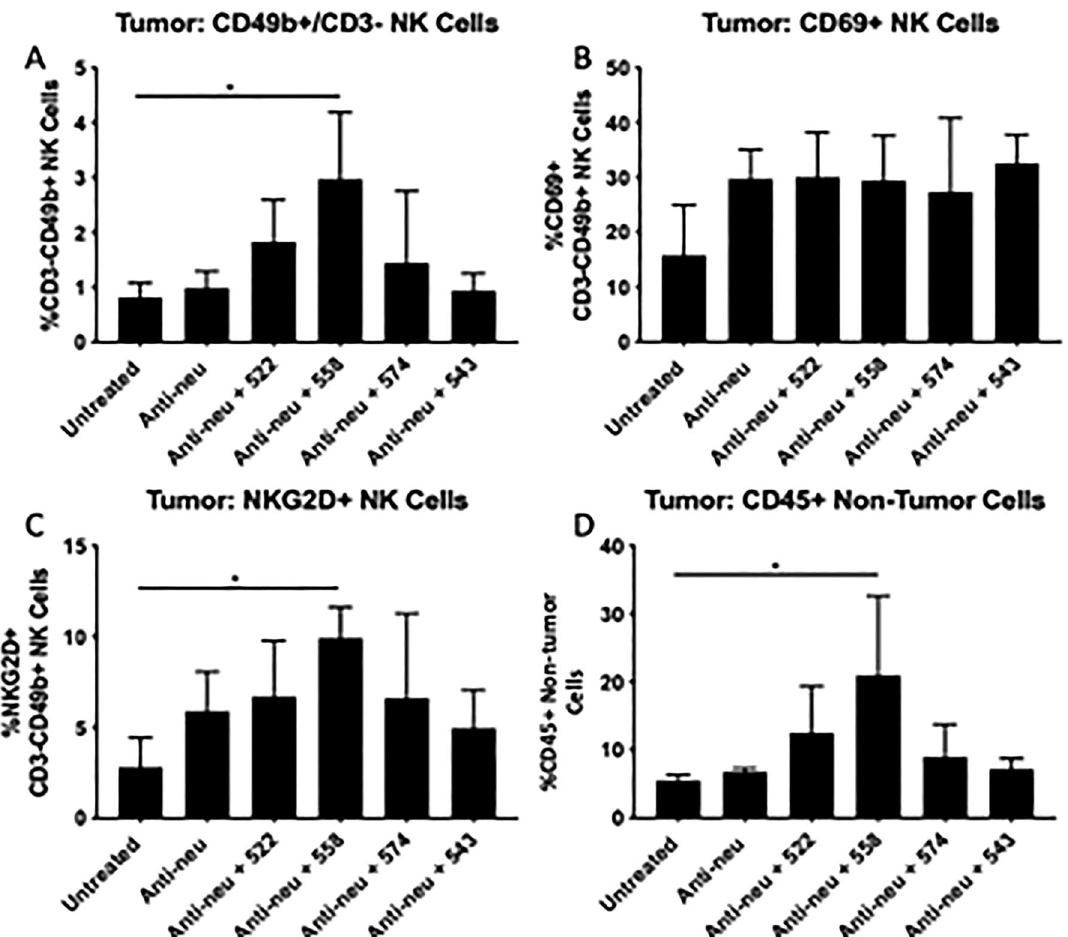
Figure 7. Ex vivo analysis of immune cell infiltration in tumor post treatment with anti-HER2/neu antibody and TLR7/8 agonists (A) Percentage of CD49b + /CD3 - NK cells in tumor, *P < 0.05 (B) Percentage of CD69 + NK cells in tumor (C) Percentage of NKG2D + NK cells in tumor, *P < 0.05 (D) Percentage of CD45 + ‘non- tumor’ cells in tumor, *P < 0.05. All statistical analysis is based on ordinary one-way ANOVA with multiple